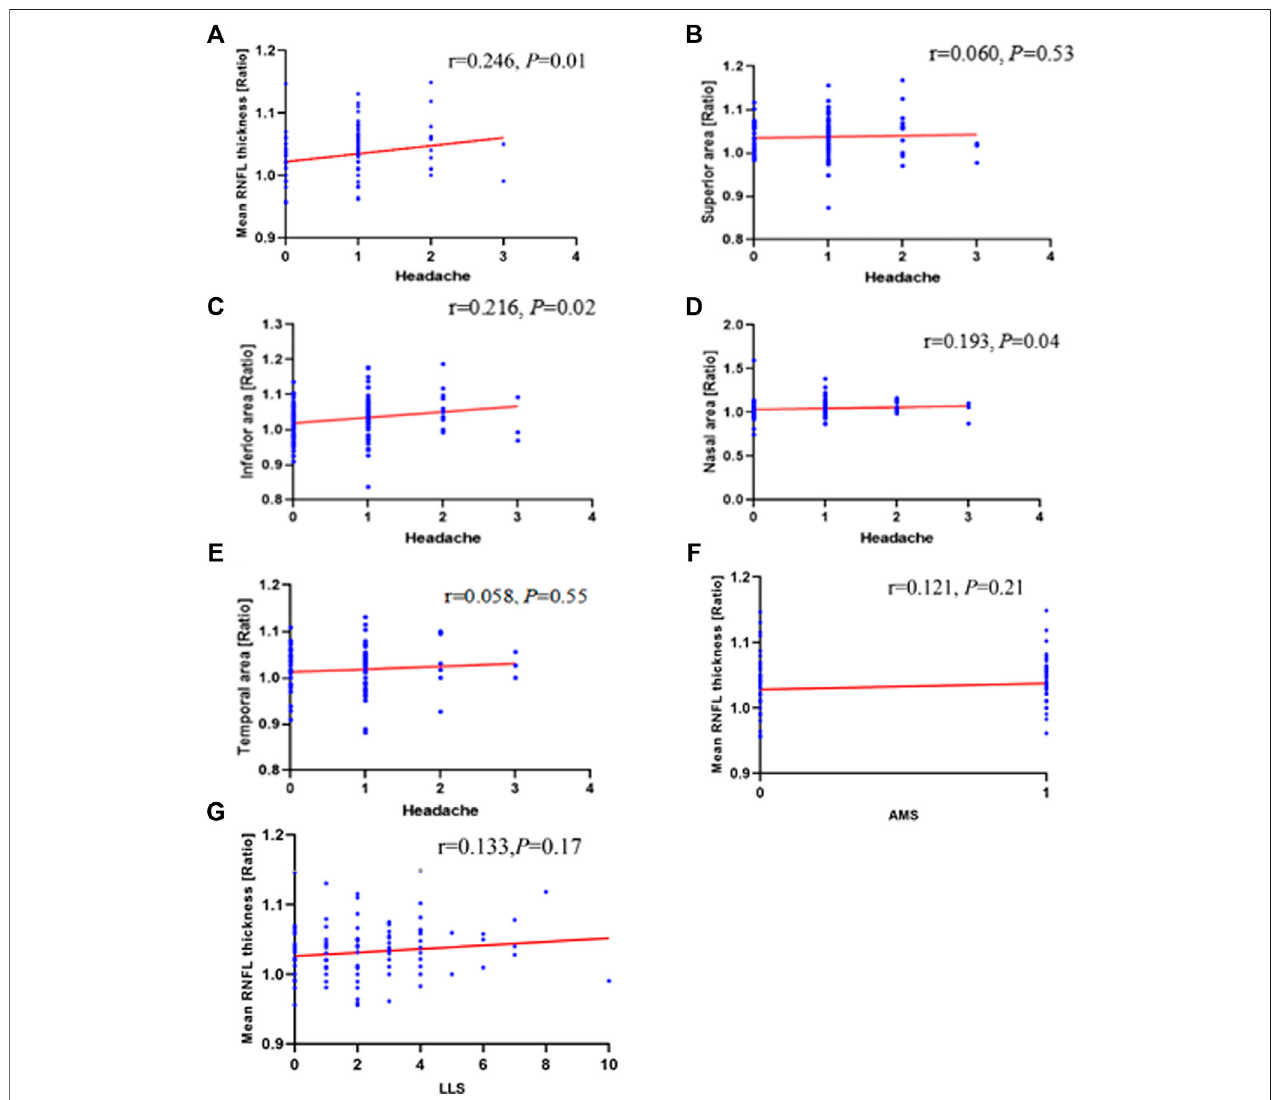
FIGURE4| CorrelationofchangesinONHwithHAHandAMSparametersduringhigh-altitudeexposure.Correlationanalysesbetween (A) meanretinalnerve fi ber layer(RNFL)thicknessratios( r =0.246; p =0.01), (B) superiorareathicknessratios( r =0.060; p =0.53), (C) inferiorareathicknessratios( r =0.216; p =0.02), (D) nasal area thickness ratios ( r =0.193; p = 0.04), (E) Temporal area thickness ratios ( r =0.058; p = 0.55) and headache. Mean retinal nerve fi ber layer(RNFL) thickness ratios does not correlate with (F) AMS ( r = 0.121; p = 0.21) or (G) LLS ( r = 0.133; p = 0.17). ONH, optic nerve head; HAH, high-altitude headache; AMS, acute mountain sickness; LLS, Lake Louise